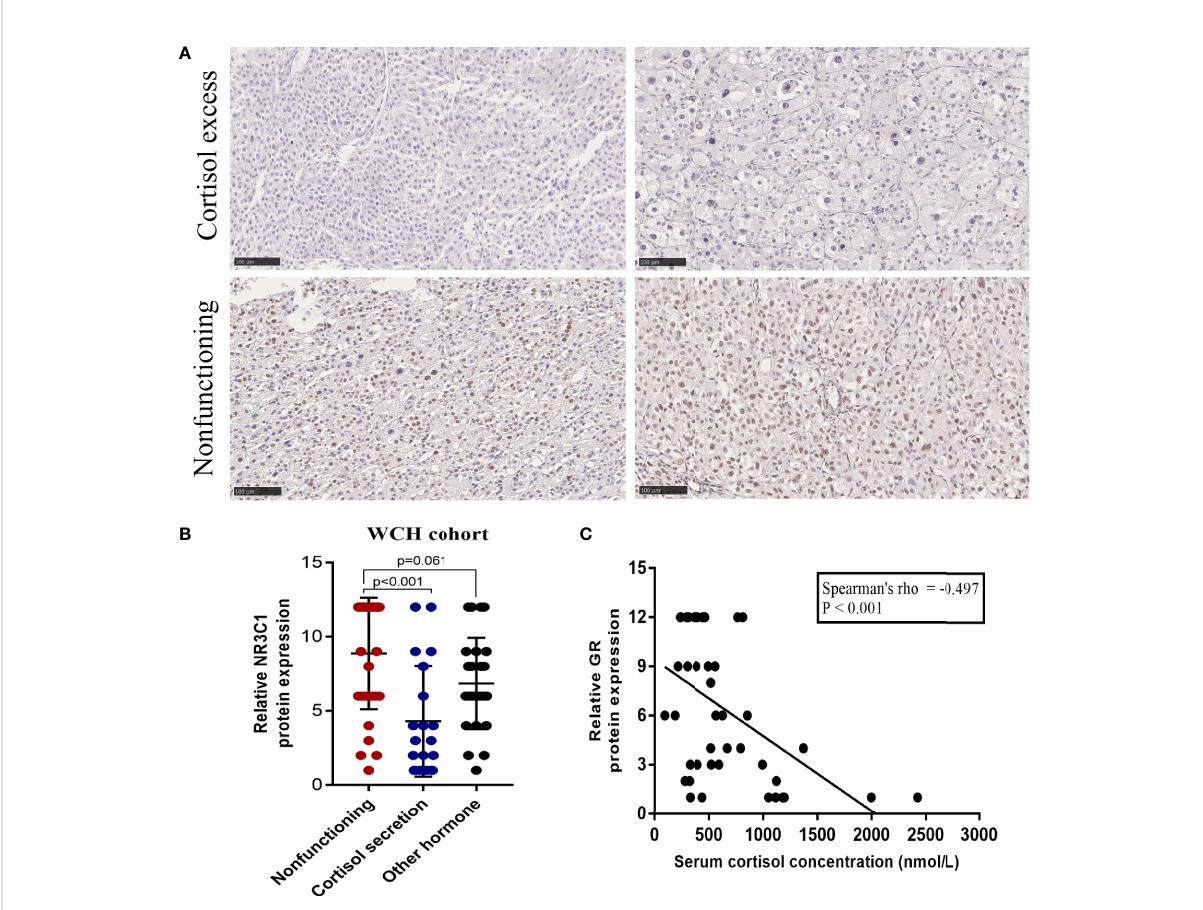
FIGURE 3 The protein expression of GR is downregulated in the cortisol-secreting ACC. (A) Representative immunohistochemical staining of GR in the nonfunctioning tumors and cortisol-secreting ACCs (100 um). (B) Protein expression of GR in nonfunctioning tumors, cortisol-secreting ACC and other hormone-secreting ACC. (C) Correlation analysis between GR expression and serum cortisol levels in patients with ACC in the WCH